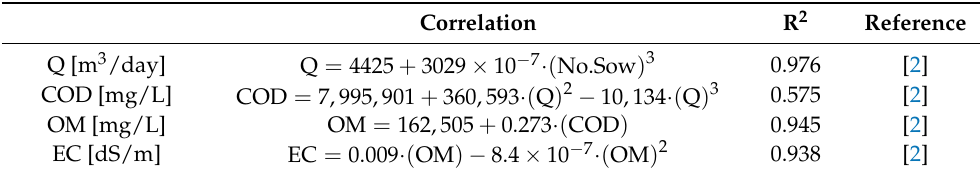
Table 2. Wastewater characterization